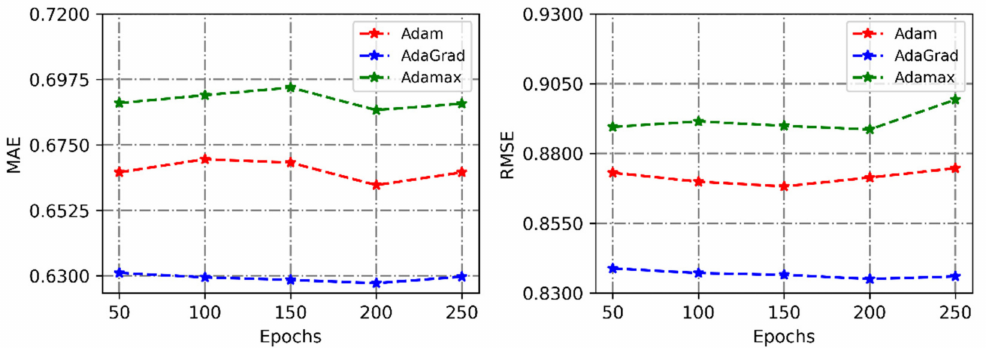
Figure 4. Comparison between Optimizers.